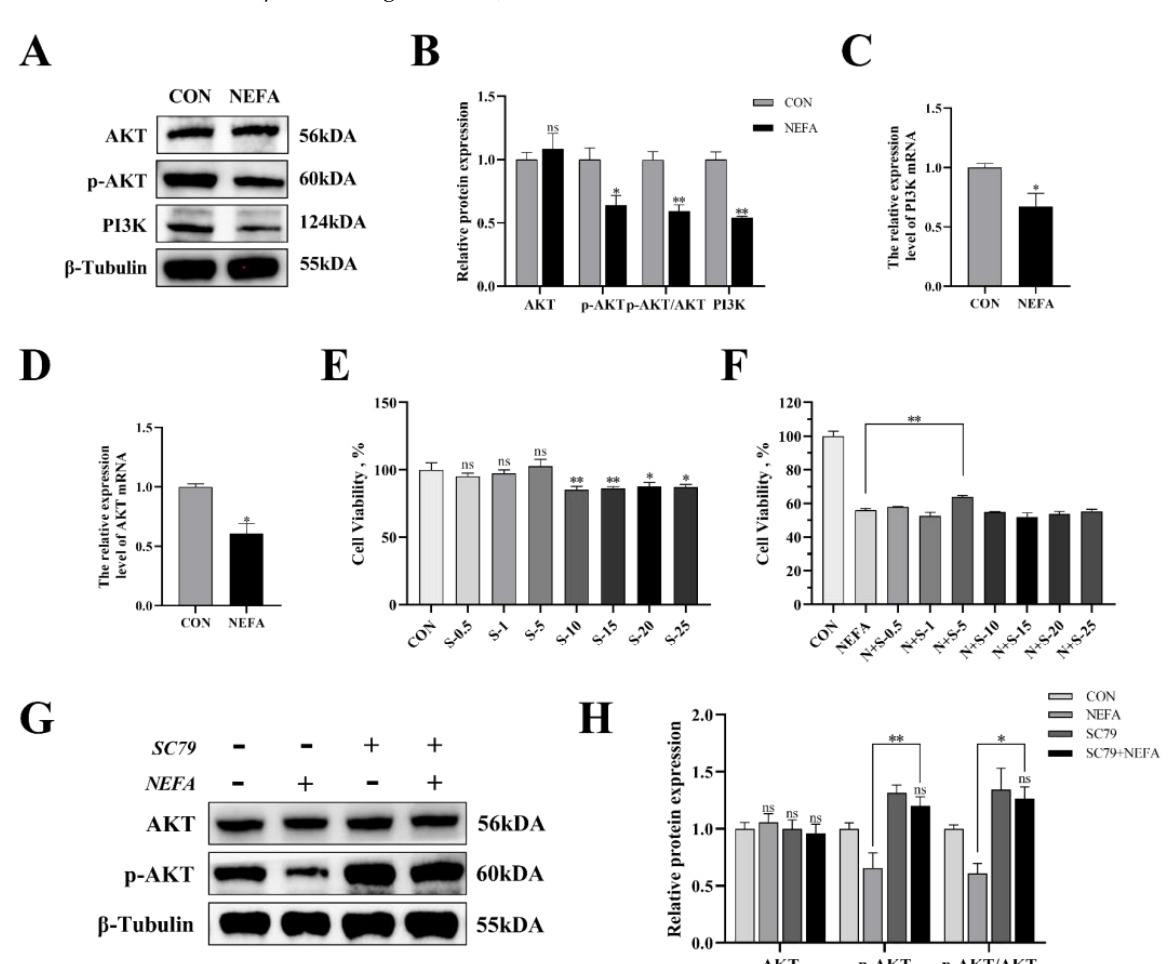
Figure 5. The effects of NEFA on the expression of PI3K/AKT pathways in BGCs and the concentra- tion screening of pathway activator SC79. BGCs were treated with or without 1.2 mM NEFA for 24 h. ( A – D ) The protein and gene expression related to PI3K/AKT pathways in BGCs were determined by qRT − PCR assay and Western blot. ( E ) The cell activity of BGCs was measured using CCK − 8 assay using different concentrations of SC79 for 2 h. ( F ) The cell activity of BGCs that were pretreated with different SC79 concentrations before NEFA treatment. ( G , H ) Detection of activation of AKT by 5 mg/mL SC79 with Western blot analysis. The quantification of the relative protein levels (performed using Image J) is shown under the band (protein/β− Tubulin). This experiment was repeated 3 times, and data are expressed as mean ± standard errors of the mean (SEM), * p < 0.05; ** p < 0.01; ns, not significant.